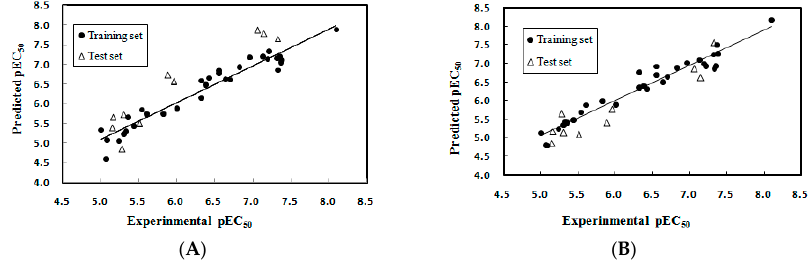
Figure 1. Plots of experimental against predicted pEC 50 values by ( A ) multiple linear regression (MLR) and ( B ) CoMFA models. Table 1. Selected descriptors of multiple linear regression.